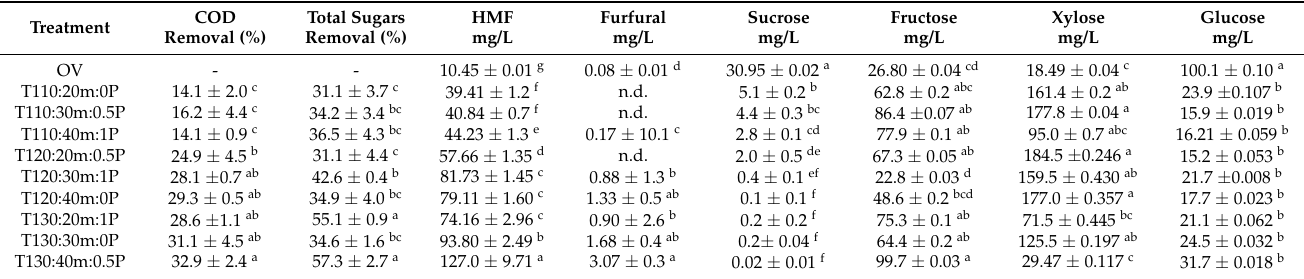
Table 1. Analysis of the elimination of COD and total sugars, formation of 5-HMF, furfural, and consumption of reducing sugars after thermal treatments.